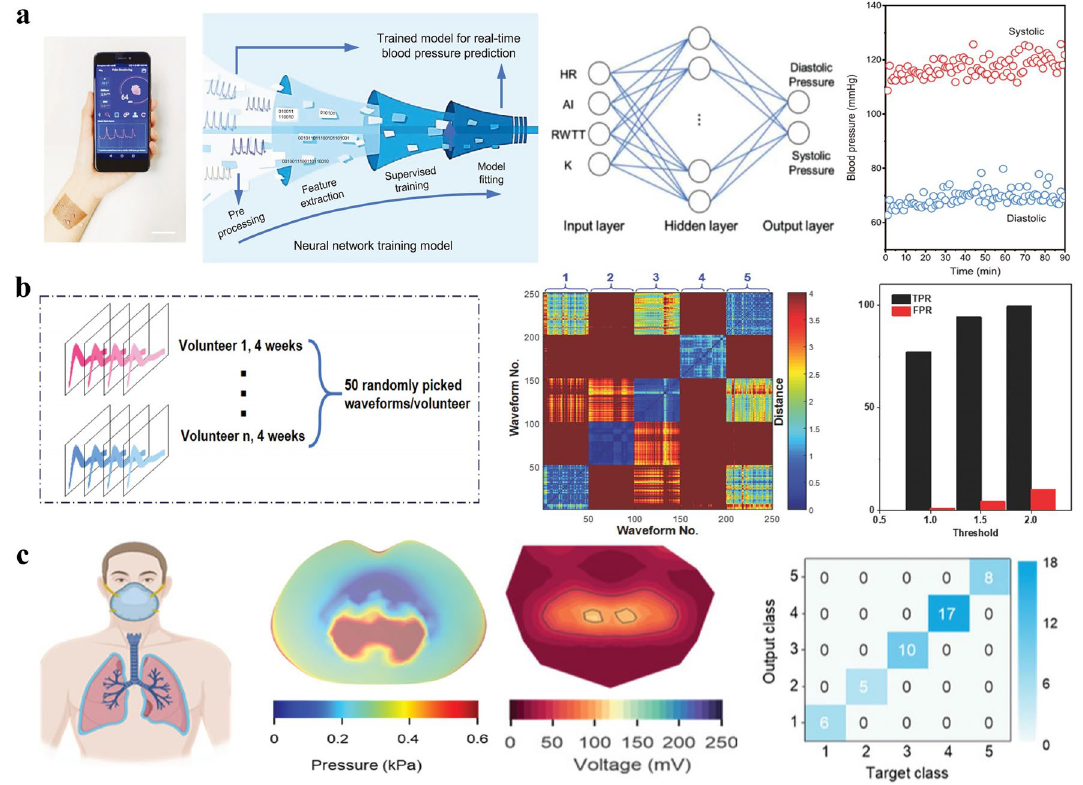
Fig. 9 a Blood pressure estimation using a textile triboelectric sensor assisted by ML techniques [14]. Copyright (2021) Wiley–VCH. b Pulse wave differentiation using a wearable piezoelectric sensing system assisted by ML techniques [13]. Copyright (2021) Wiley–VCH. c Respiration pattern differentiation using an on-mask triboelectric sensor network assisted by ML techniques [169]. Copyright (2022)